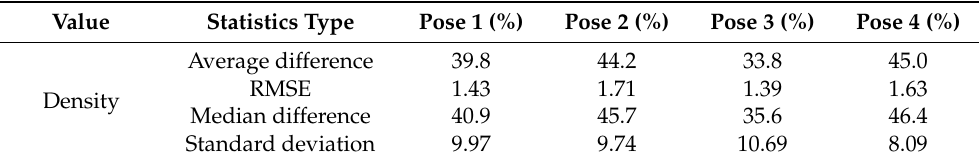
Table 8. Statistics for the differences between predicted and evaluated density for different human poses with outliers